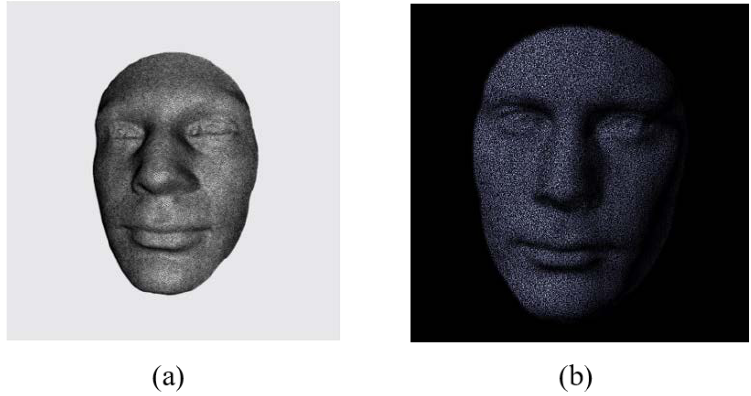
Figure 8. Numerical reconstruction of “Alex”: ( a ) 3D mesh of Alex and ( b ) numerical reconstruction. The geometric surface with the texture image in ( a ) is from a publicly accessible geometric archive from the 3D Scanning Laboratory in Stony Brook University